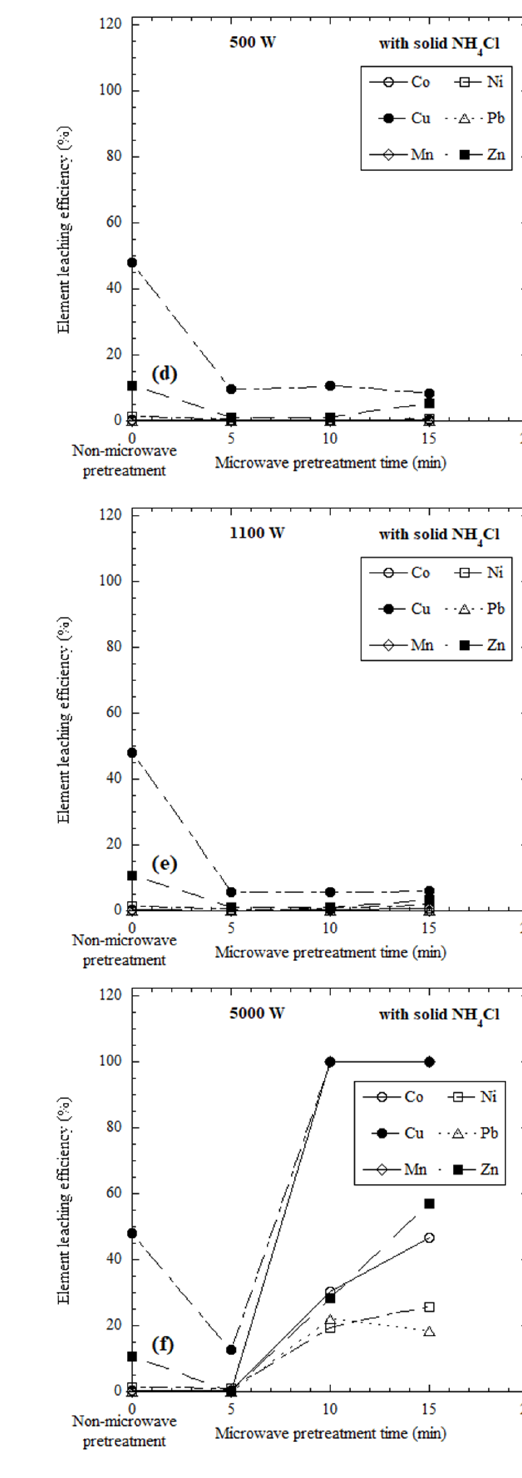
Figure 5. Cr, V, and As leaching efficiency at various output powers: ( a ) 500 W, ( b ) 1100 W, and ( c ) 5000 W and Co, Cu, Mn, Ni, Pb, and Zn leaching efficiency at various output powers: ( d ) 500 W, ( e ) 1100 W, and ( f ) 5000 W from the red mud-solid NH 4 Cl microwave-pretreated at various output powers. Table 4. Semi-quantitative mineralogical analysis results using the Rietveld method of microwave-heated red mud-solid NH 4 Cl at 5000 W.